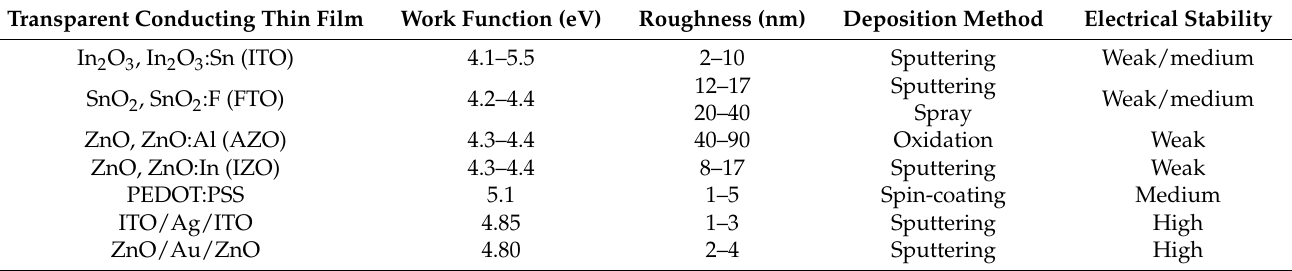
Table 1. Summary of most of the transparent electrode properties available for third-generation solar cell architectures.